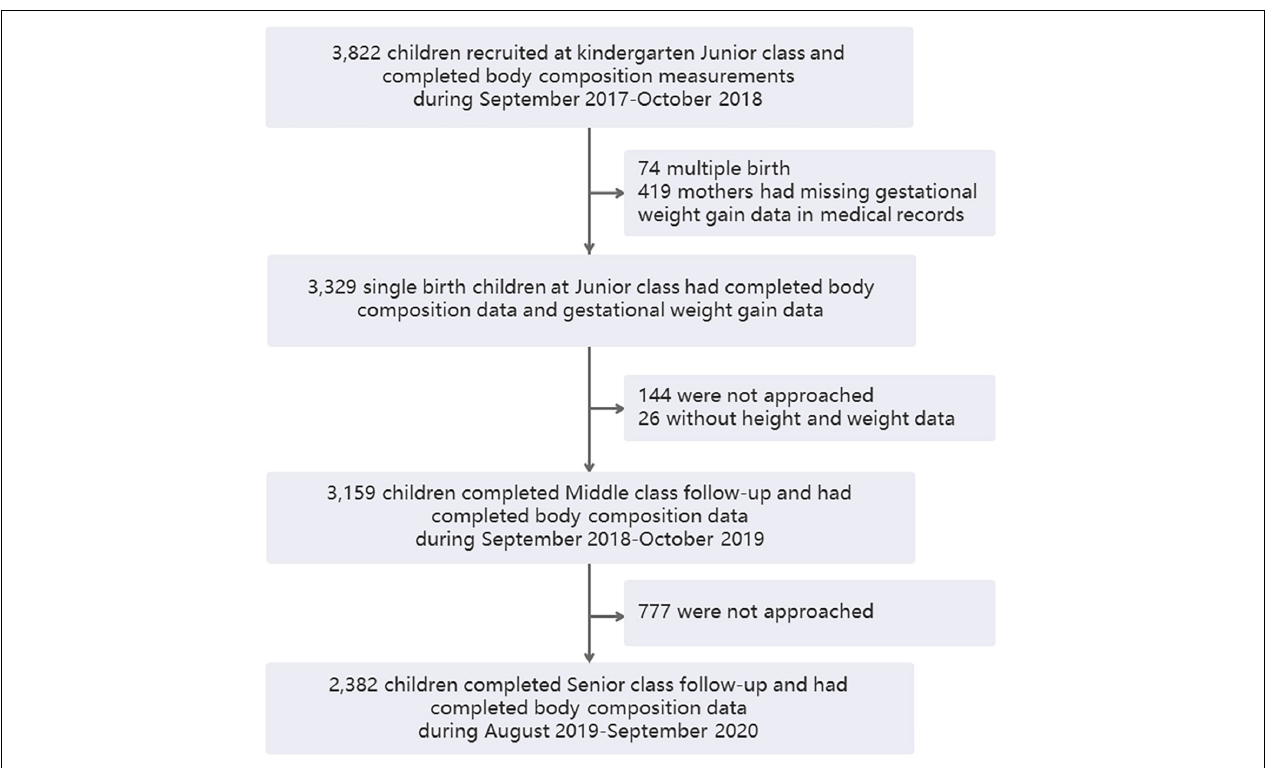
FIGURE 1 | Flowchart of the study